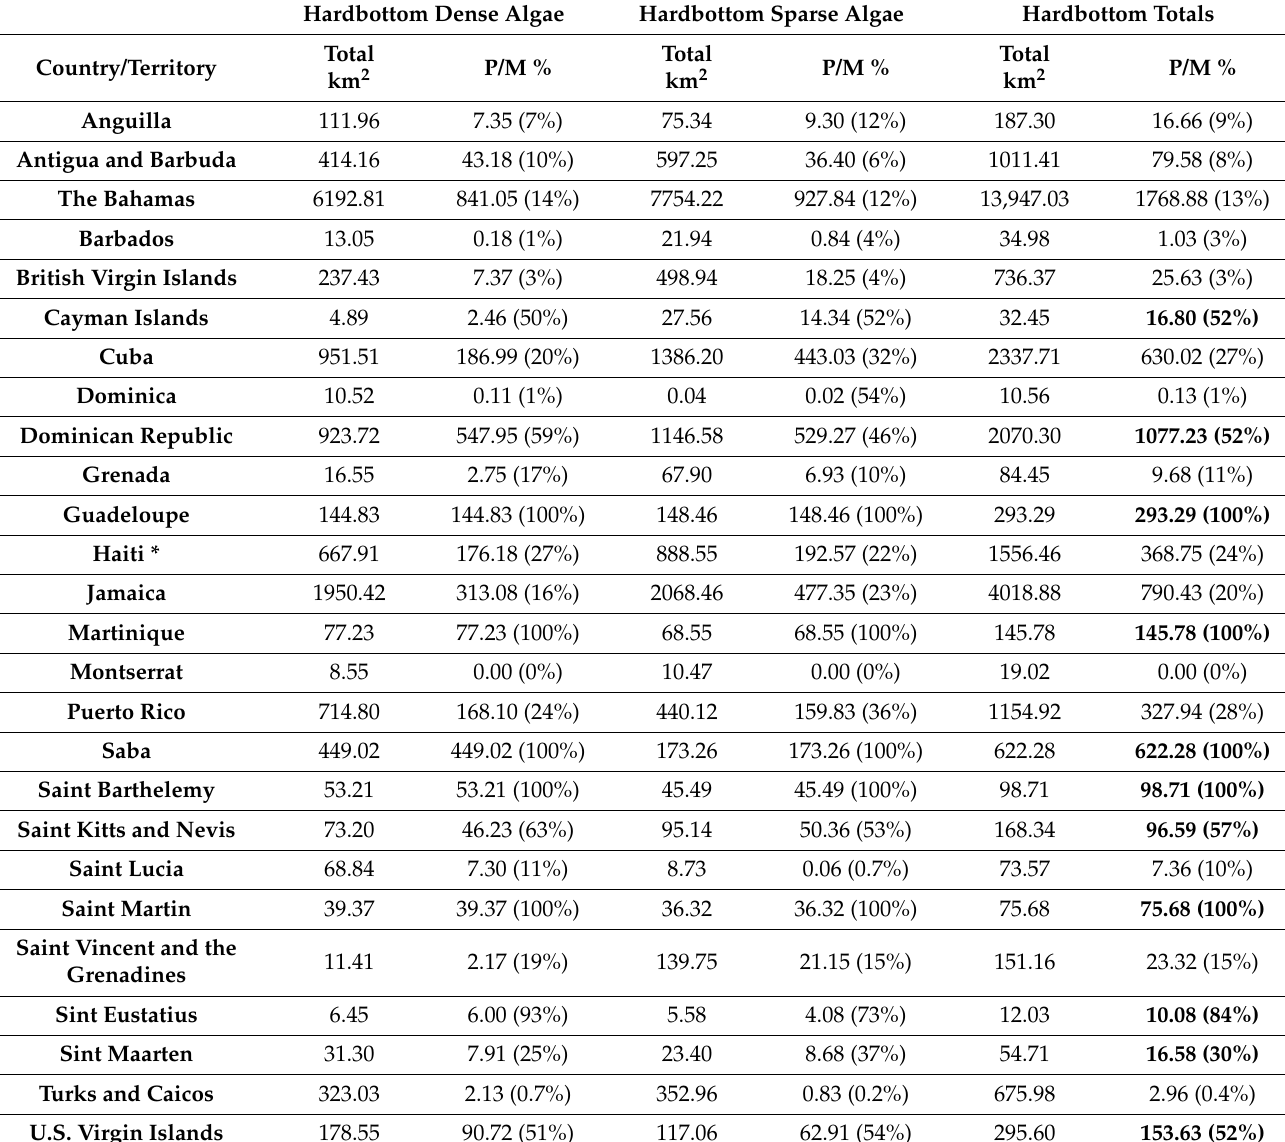
Table 7. Total area (km 2 ) of hardbottom benthic habitat classes within the shallow marine zone (<30 m depth) of the Insular Caribbean per EEZ and corresponding area and percentage within declared marine protected or managed areas (P/M %). The total hardbottom protection percentages in bold indicate attainment of at least